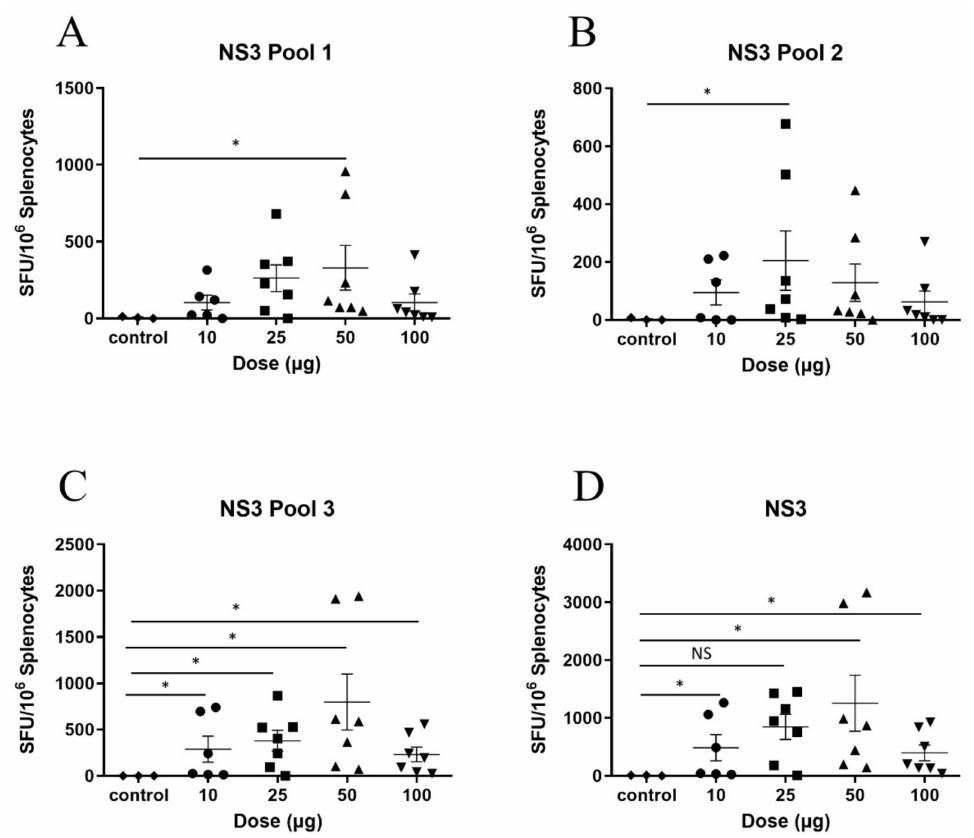
Figure2. TitrationofpNS3inC57BL / 6mice. Micewerevaccinatedthreetimesattwoweekintervalswith pNS3 and splenocytes were harvested 14 days post final vaccination. Splenocytes were re-stimulated in duplicate with overlapping peptides representing the complete HCV NS3 protein (gt3a) and IFN- γ secretion detected by ELISpot analysis. Splenocytes from vaccinated animals were re-stimulated with overlapping peptides representing ( A ) NS3 pool 1 ( B ) NS3 pool 2 ( C ) NS3 pool 3 ( D ) NS3 combined analysis. Each symbol represents an individual mouse and data are shown as mean ± SEM of SFU per 10 6 splenocytes. Significance shown between control and dose groups. No significant di ff erences were observed between dose groups. * p ≤ 0.05 (Mann–Whitney test non-parametric t